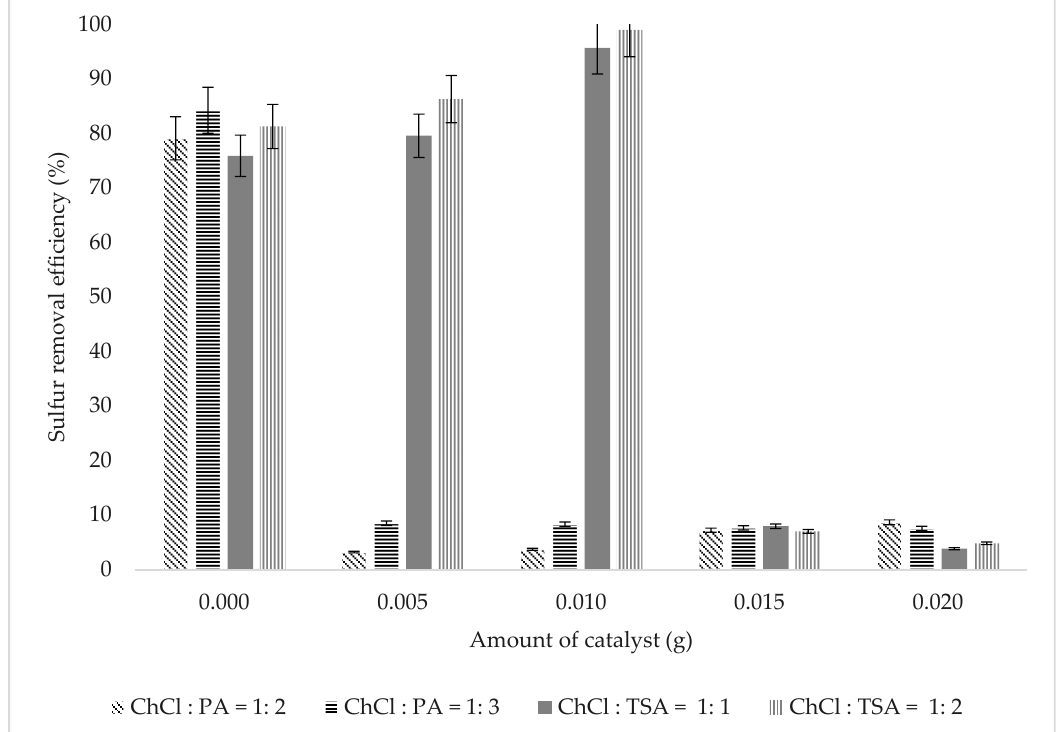
Figure 2. The effect of catalyst dosage on the sulfur removal efficiency (H 2 O 2 as an oxidant with a ratio to DBT of 1:2, 10 mL of 100 ppm model oil (DBT), room temperature, EIL to model oil ratio of 1:5, and 300 rpm stirring speed).